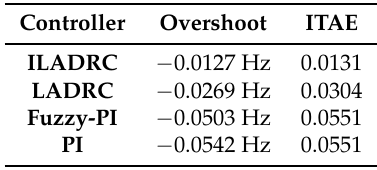
Table 9. Performance comparison with ILADRC, LADRC, PI and Fuzzy-PI controller under stochastic power of wind turbine generator and +0.2 p.u. change of load demand.